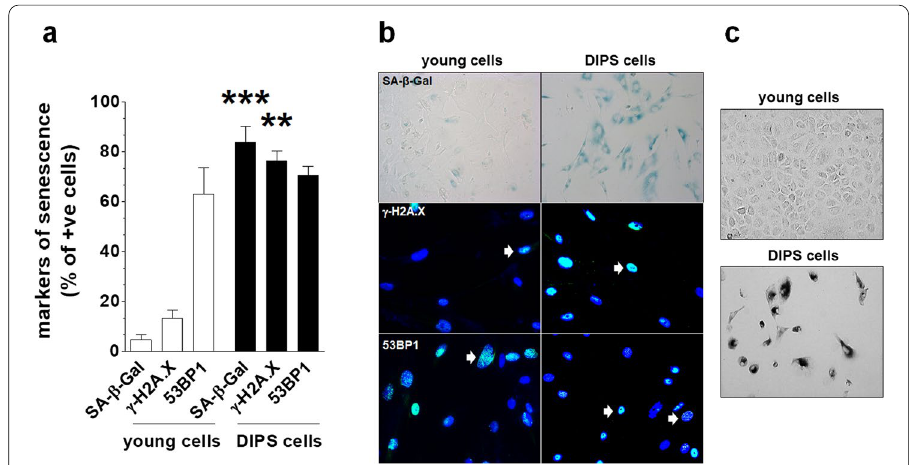
Fig. 1 Development of the senescence phenotype in HGSOCs treated with CPT‑PCT. For details regarding the procedure of CPT‑PCT‑dependent senescence induction please refer to “Methods”. Quantification of the fraction of cells displaying biochemical (SA‑β‑Gal) and molecular (γ‑H2A.X, and 53 BP1) markers of cellular senescence in young and DIPS cancer cells ( a ). Representative staining against senescence biomarkers. SA‑β‑Gal‑positive cells are characterized by green cytoplasm. White arrows indicate exemplary γ‑H2A.X‑ and 53BP1‑ positive cells ( b ). Representative illustrations of young and DIPS cells’ appearance obtained upon changing the color image to black and white, sharpening and increasing contrast in cells stained for SA‑β‑Gal ( c ). Magnification 200, objective aperture 0.35. The results are based on 6–8 independent experiments × using HGSOCs obtained from different patients. The results are expressed as the means